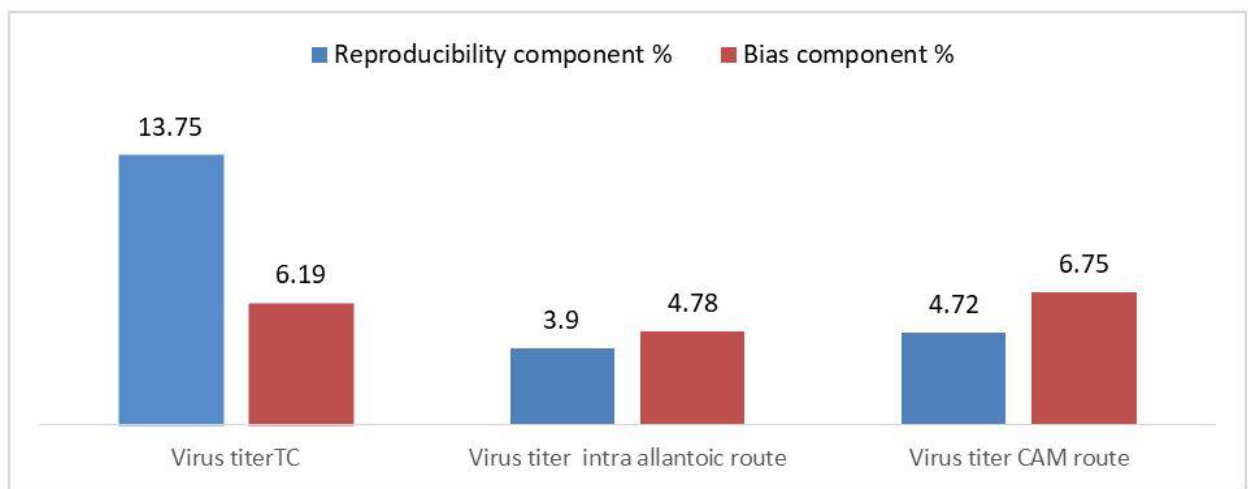
Fig.10: Uncertainty and its Component for Different Methods.